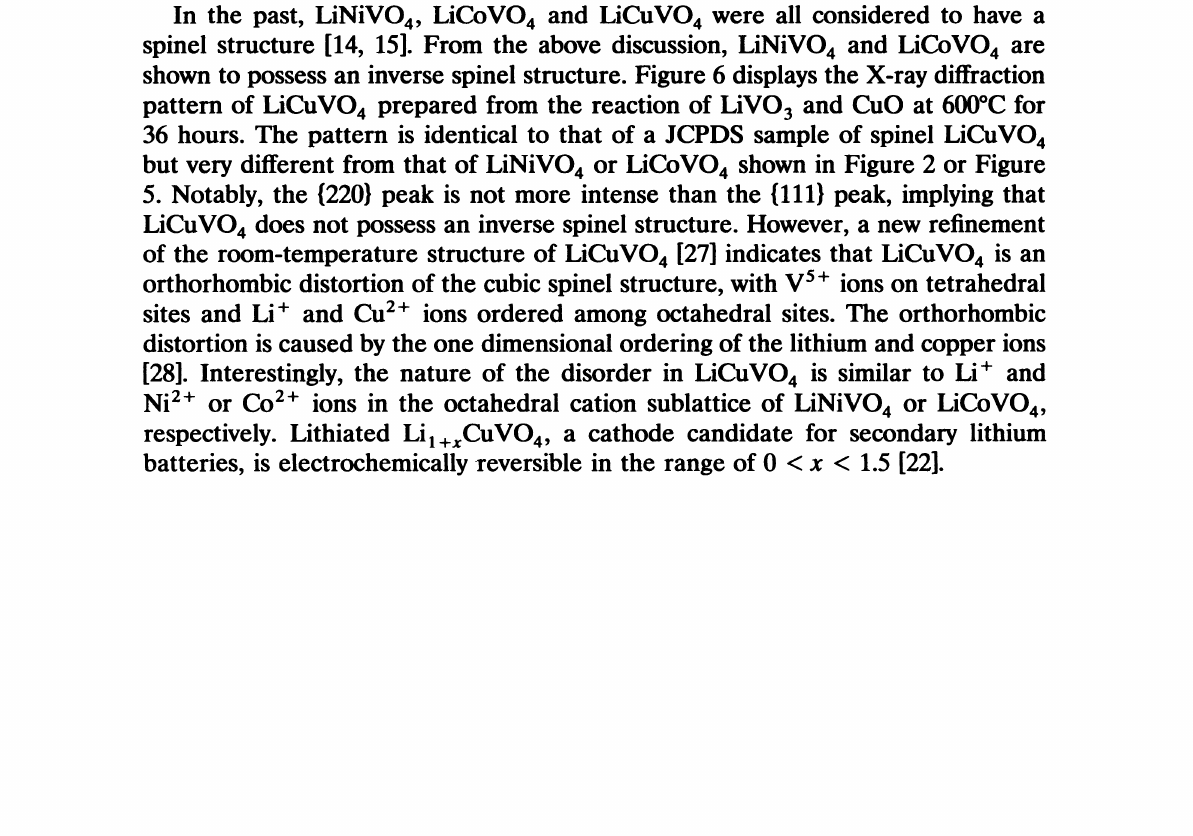
Prepared from the Reaction of LiVO and 4